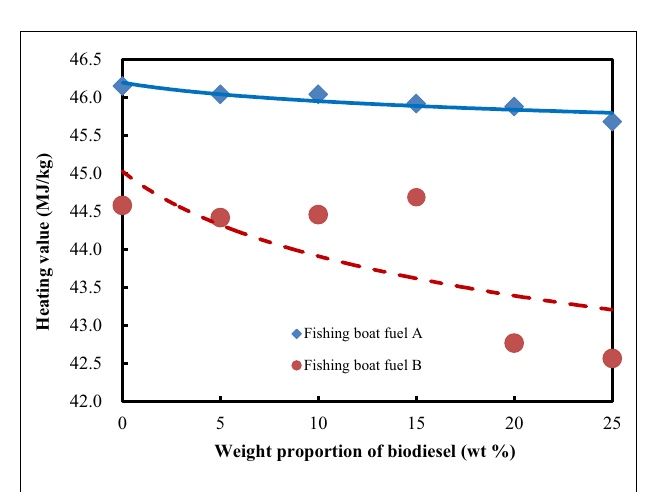
FIGURE 2 |Variation in flash point according to the weight proportion of biodiesel-blended in fishing boat fuelsA and B .